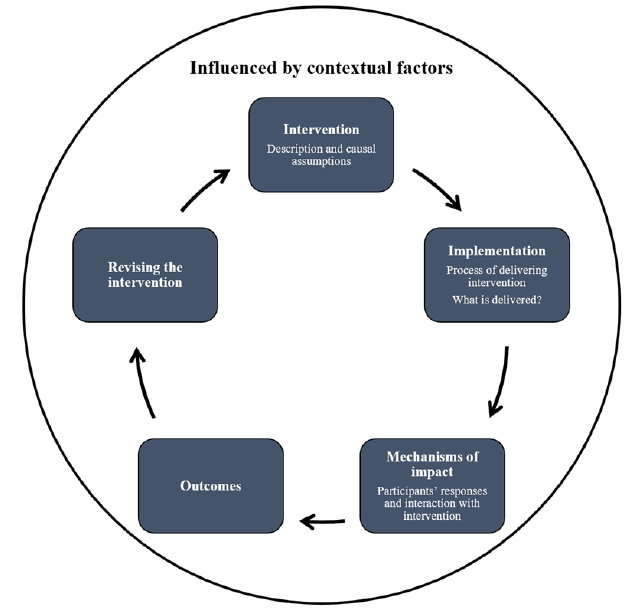
Figure 1. Process evaluation framework (Moore et al., 2014).